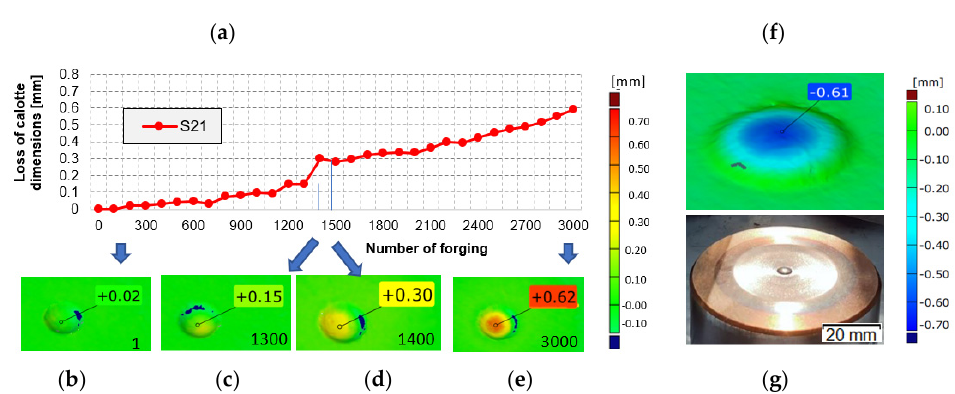
Figure 9. ( a ) Results of reverse scanning of the changes in the punch calotte’s imprint depth in the forgings: ( b ) 1st forging, ( c ) 1300th forging, ( d ) 1400th forging, ( e ) 3000th forging, ( f ) a calotte scan at the end of operation, ( g ) image of the punch.